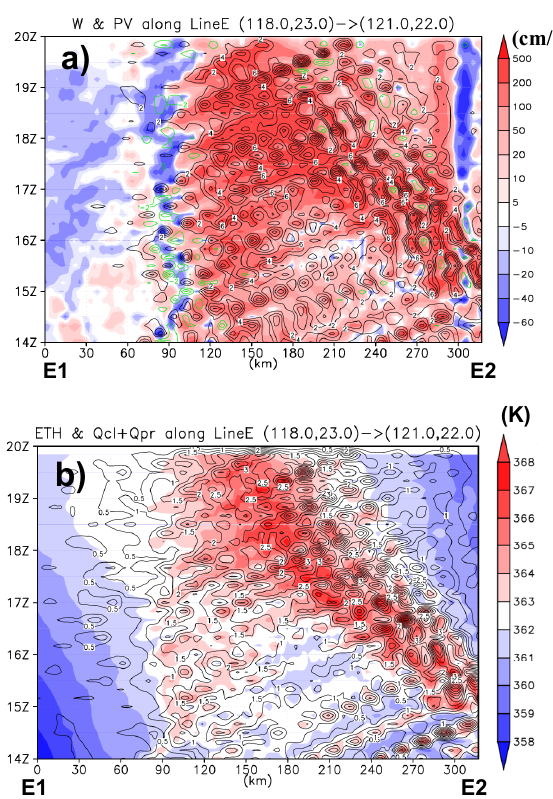
Fig. 11. Simulated results of the temporal variation along cross- section line E1–E2 in Fig. 10b from 14:00UTC to 20:00UTC 7 August. (a) vertical velocity fields (colored shades: positive in red and negative in blue) and potential vorticity (contours: positive in black and negative in green, interval: 2PVU) (b) Same as (a) but for theata-e and total precipitation mixing ratio.